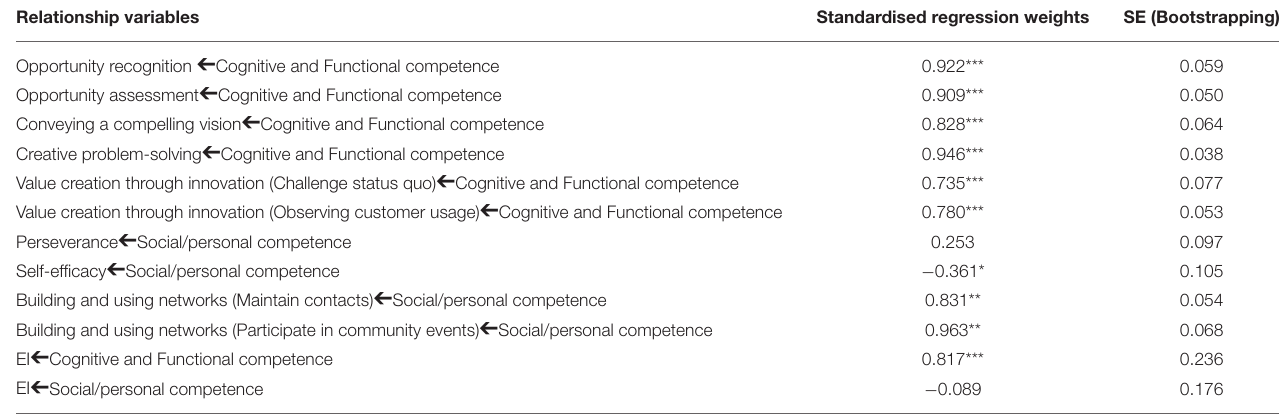
TABLE 5 | Bootstrapped standardised regression weights and SE. Relationship